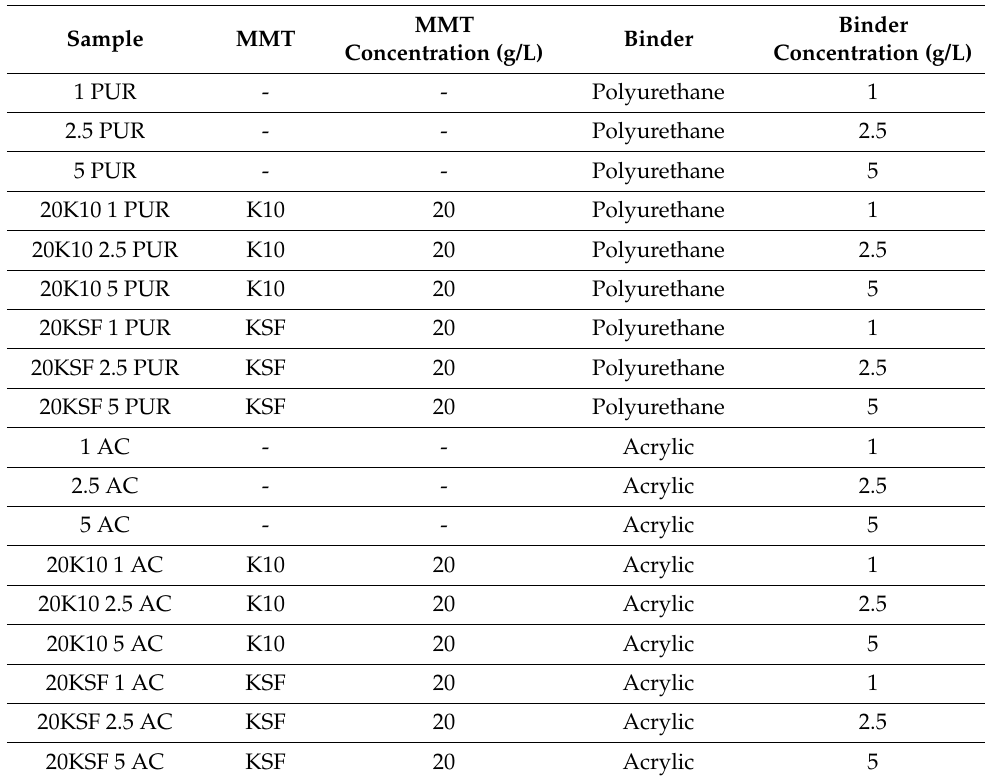
Table 2. Formulation used in each fabric